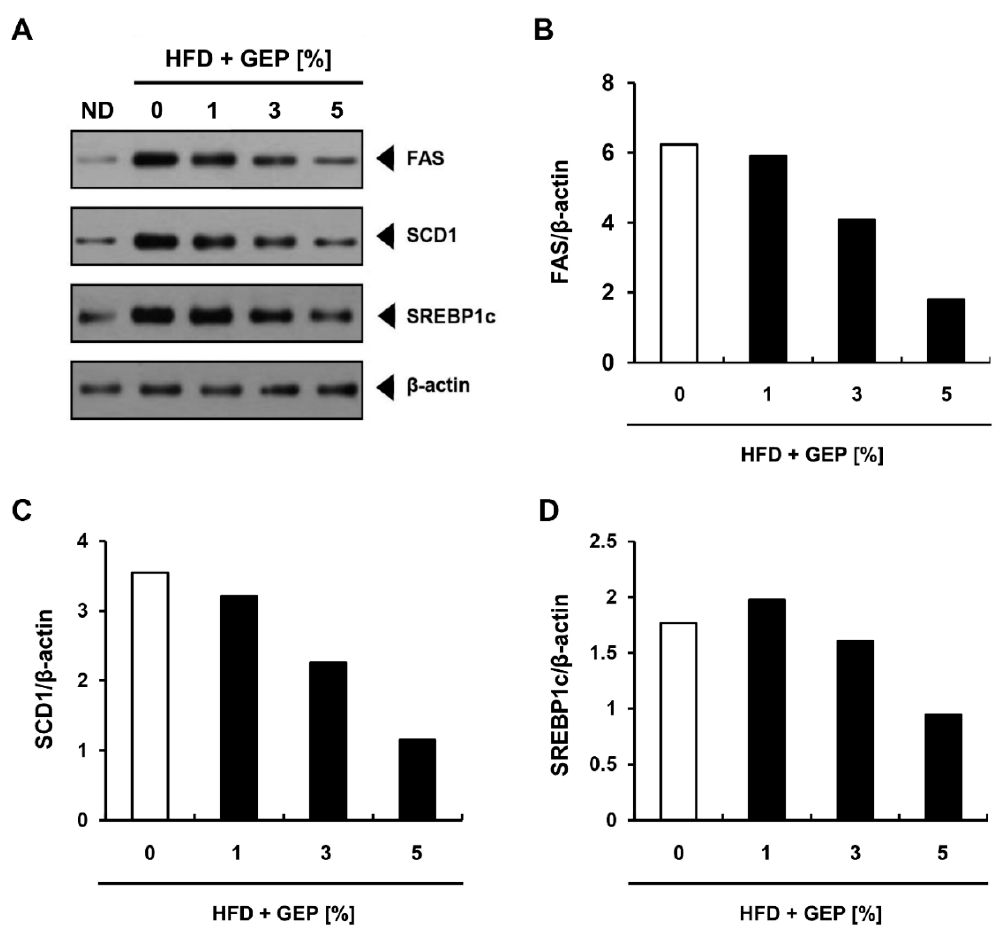
Figure 8. E ff ect of GEP on lipogenesis-related protein expression. ( A ) Western blot analysis and the expression of ( B ) FAS, ( C ) SCD1, and ( D ) SREBP1c relative to β -actin. ND: normal chow diet group (control); HFD: high-fat diet group; HFD + GEP: high-fat diet and Ganoderma lucidum extract powder. GEP supplementation in HFD-induced obese mice enhanced AMPK phosphorylation, leading to however, GEP did not a ff ect the expression of AMPK or